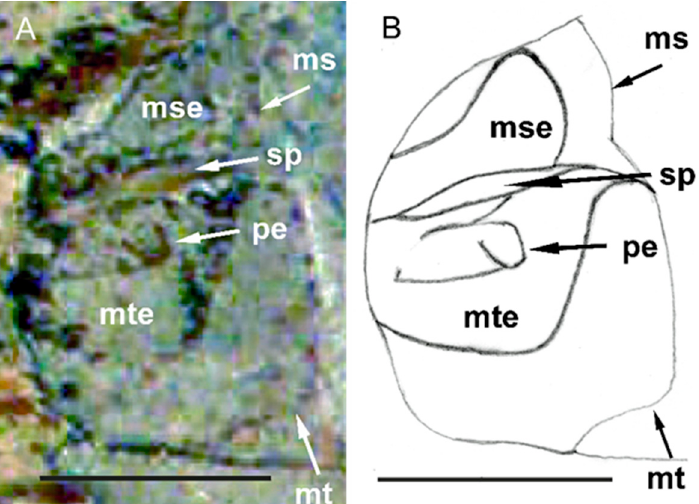
Figure 3. Holotype specimen of E. lisi , meso- and metathorax. ( A ) Original photograph [7], modified; courtesy of the Cambridge University Press. ( B ) Line-drawing reconstruction (by J.A. Lis). Mesopleuron (ms), mesopleural evaporatorium (mse), metapleuron (mt), metapleural evaporatorium (mte), peritreme (pe), metathoracic spiracle (sp). Scale bars = 1.0 mm.